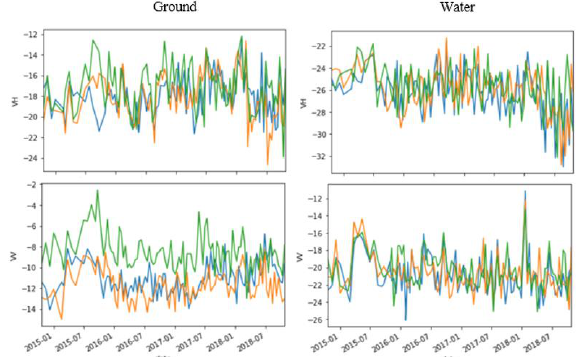
Figure 4. The temporal signature of ground samples (L) and water samples (R), in VH and VV.